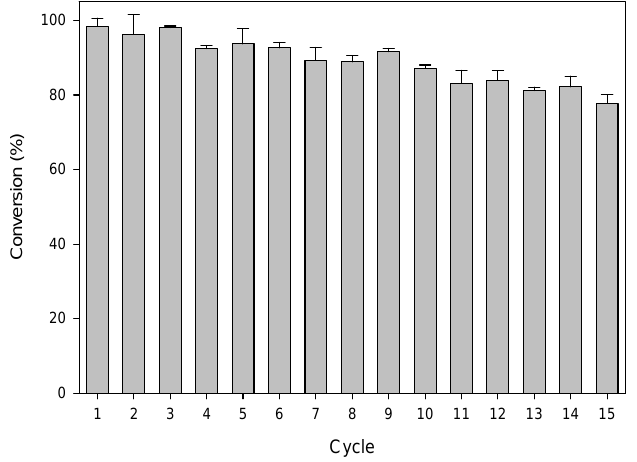
) N -carbamoyl- D -methionine, (cid:35)